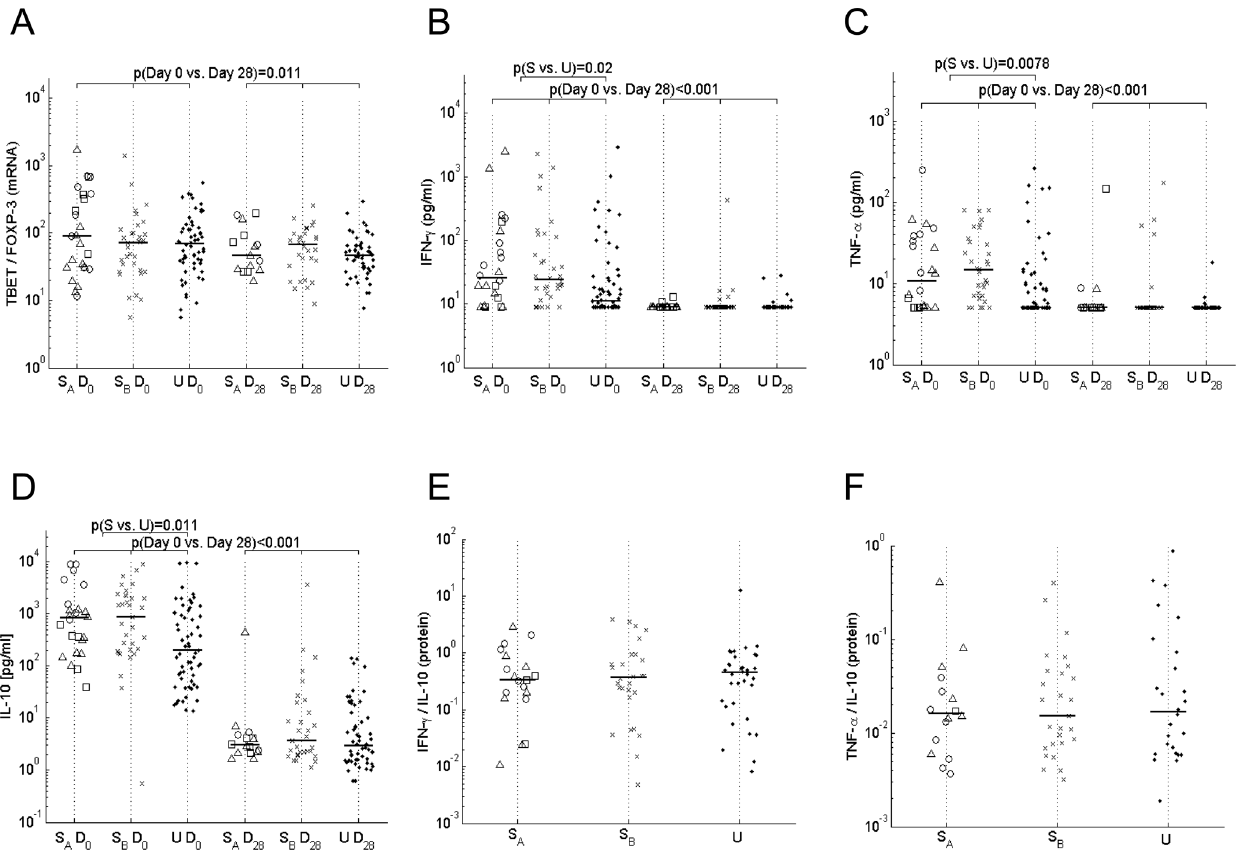
Figure 5. Ratios of Th1 over Treg cells and pro-inflammatory over regulatory cytokines. (A) Ratio of the mRNA level of the Th1 transcription factor T-BET over FOXP3 for uncomplicated and severe cases during the acute phase (D0) and convalescence (D28) as determined by RT- PCR. Plasma levels for (B) IFN- c , (C) TNF- a , and (D) IL-10 measured with a bioplex system and the ratios of (E) IFN- c /IL-10 protein as well as (F) TNF- a / IL-10 protein on day 0. (NB: Protein ratios could not be calculated for Day 28, since cytokine concentrations were rarely above the detection limit of the assay. In Figure 5E and 5F only ratios for samples that had detectable responses for both cytokines on Day 0 are shown) Symbols, bars and p- values as defined in Figure 1.